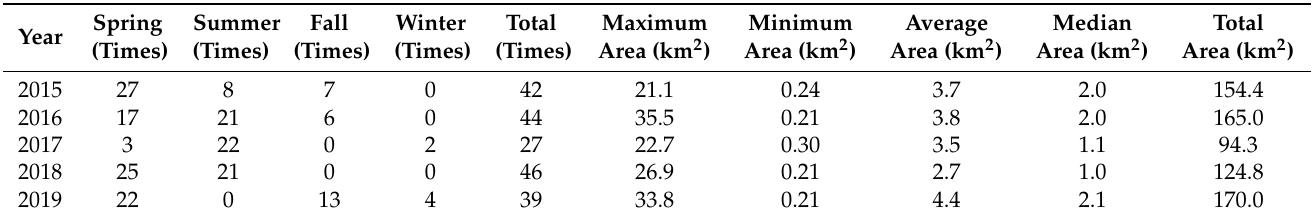
Table 3. Statistical data for delineated oil slicks in the Beibu Gulf.